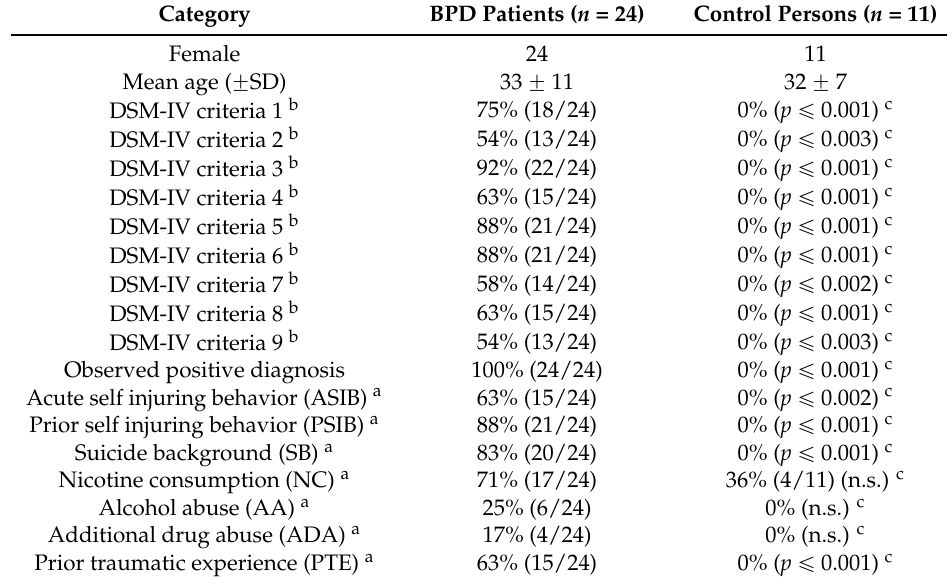
Table 1. Summarized data of the analyzed patients with BPD and control persons a